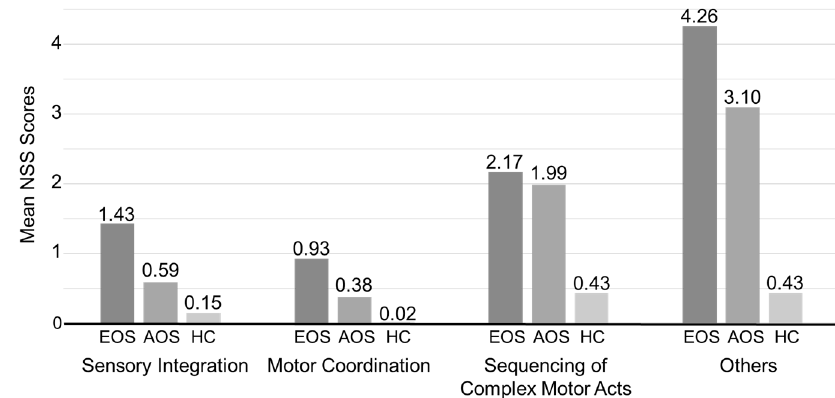
Figure 1. Mean neurological soft sign (NSS) scores in early-onset schizophrenia (EOS) patients, adult-onset schizophrenia (AOS) patients, and healthy controls (HC).